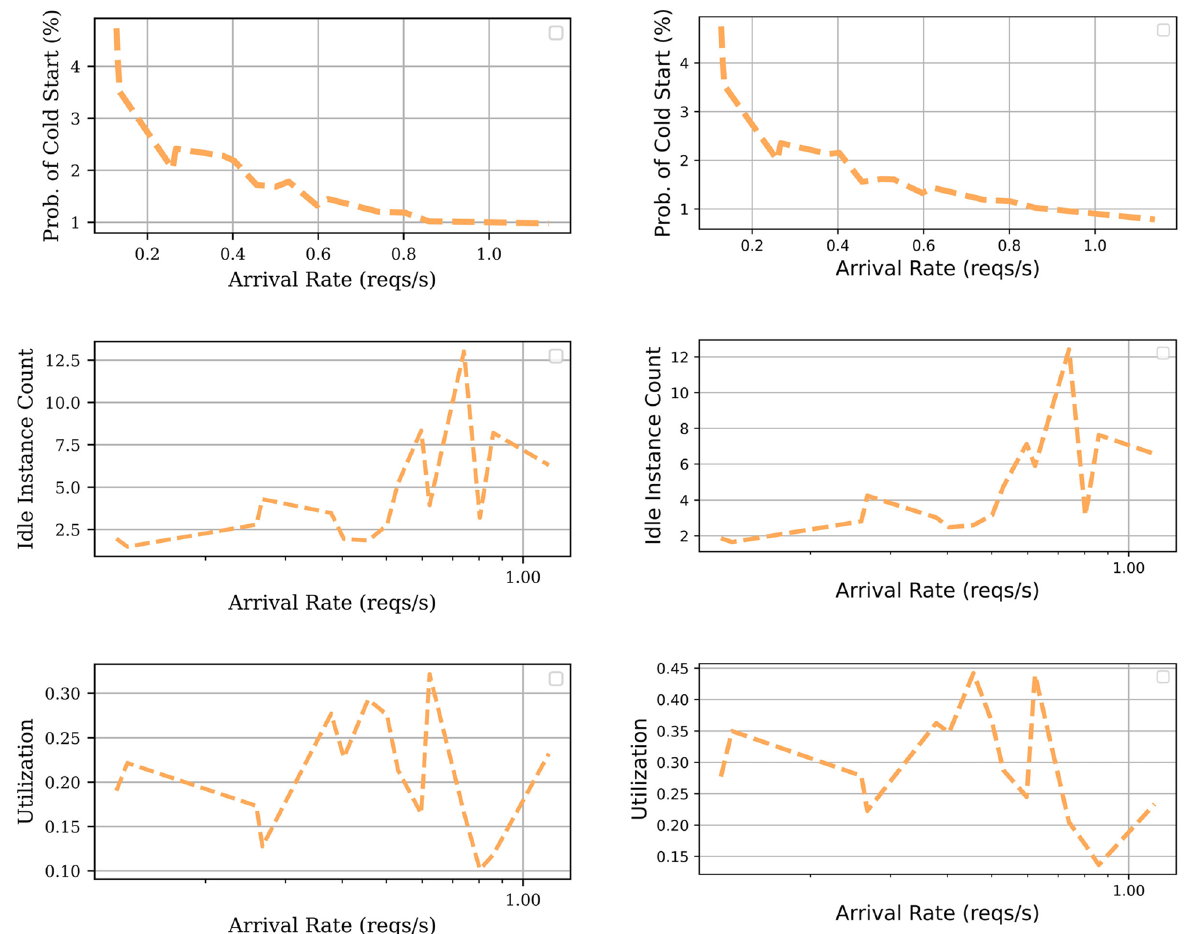
Fig. 6 Performance metrics extracted from simulation, Left-figures: simFaaS, Right-figures: our